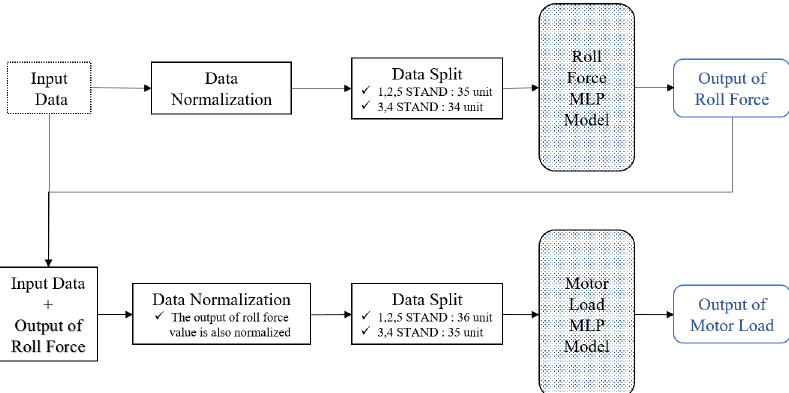
Figure 5. Detailed procedure for the roll force and motor load prediction algorithm. Each network is trained by gradient descent method error back propagation algorithm [43] with the errors E as